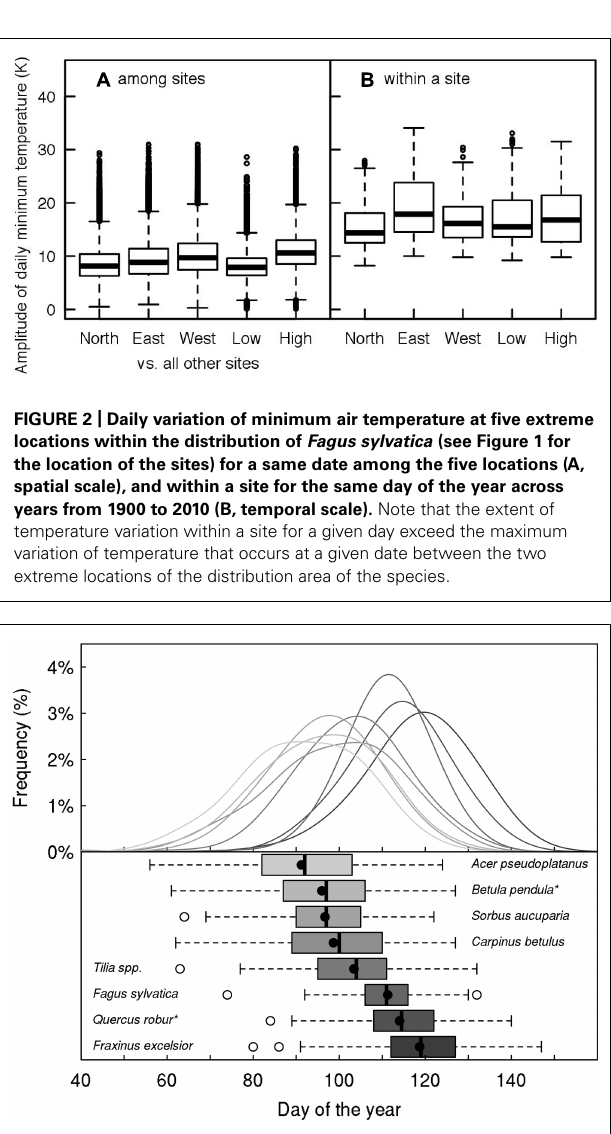
FIGURE 3 | Marsham phenological records (Sparks and Carey, 1995). The upper panel shows the frequency of distribution of the leaf-out dates in Norfolk (UK) for eight temperate tree species over the period 1736–1958 (between 158 and 178 years available, depending on species).The distribution was fitted by a Gaussian–Kernel density distribution with a bandwidth of 7 days for each species.The box-plots show median, quartiles, and extremes of the phenological data, with the mean given as filled circle. Species names followed by an asterisk indicate that this is the probable species but we are